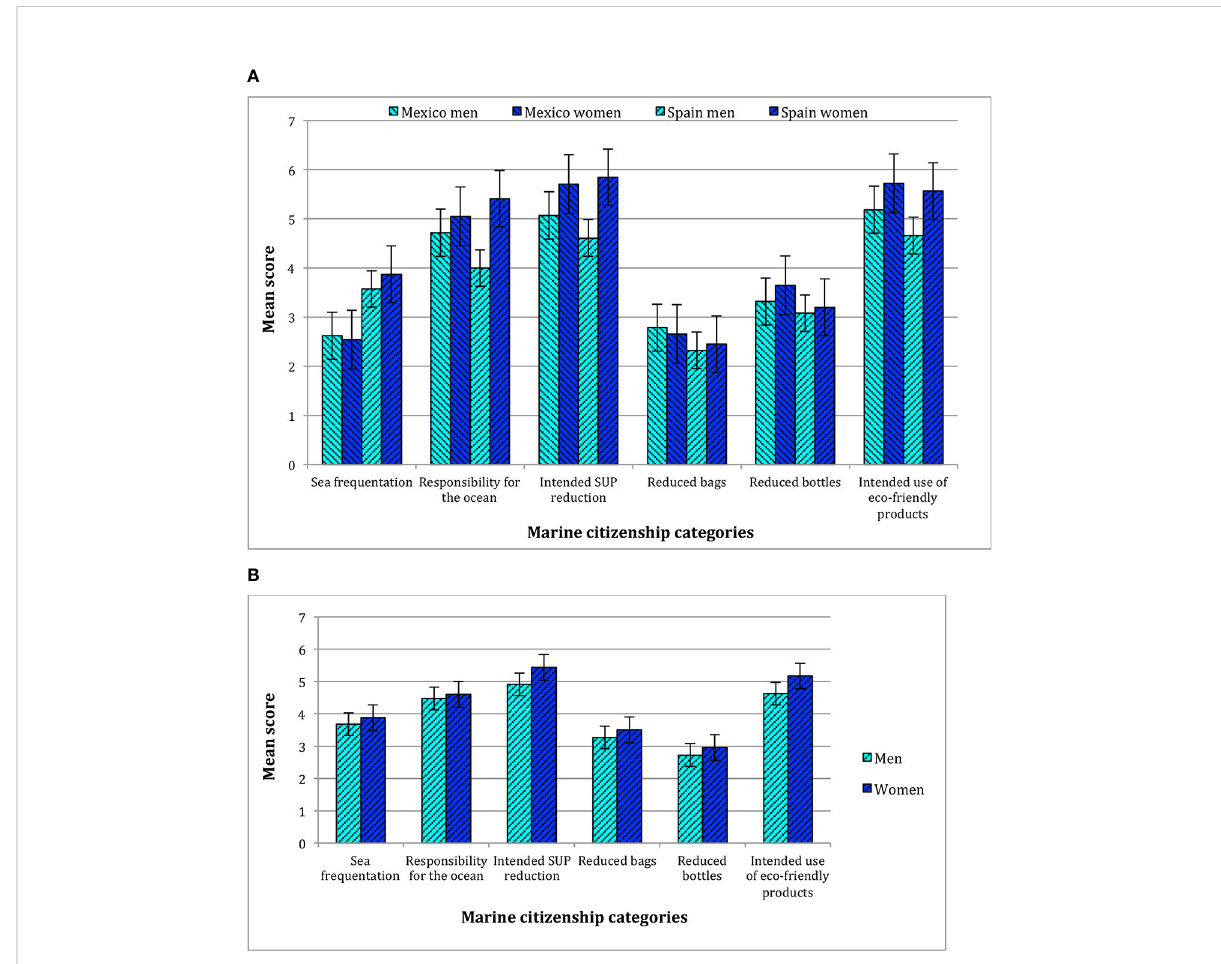
FIGURE 2 Marine citizenship measured from sea frequentation and feeling of responsibility for the ocean and single-use plastics consumption behavior (as reduced use of these items) in the Mexican and Spanish samples of students (A) and the Spanish sample of non-students (B) analyzed. Results are presented as mean scores, with standard errors as capped